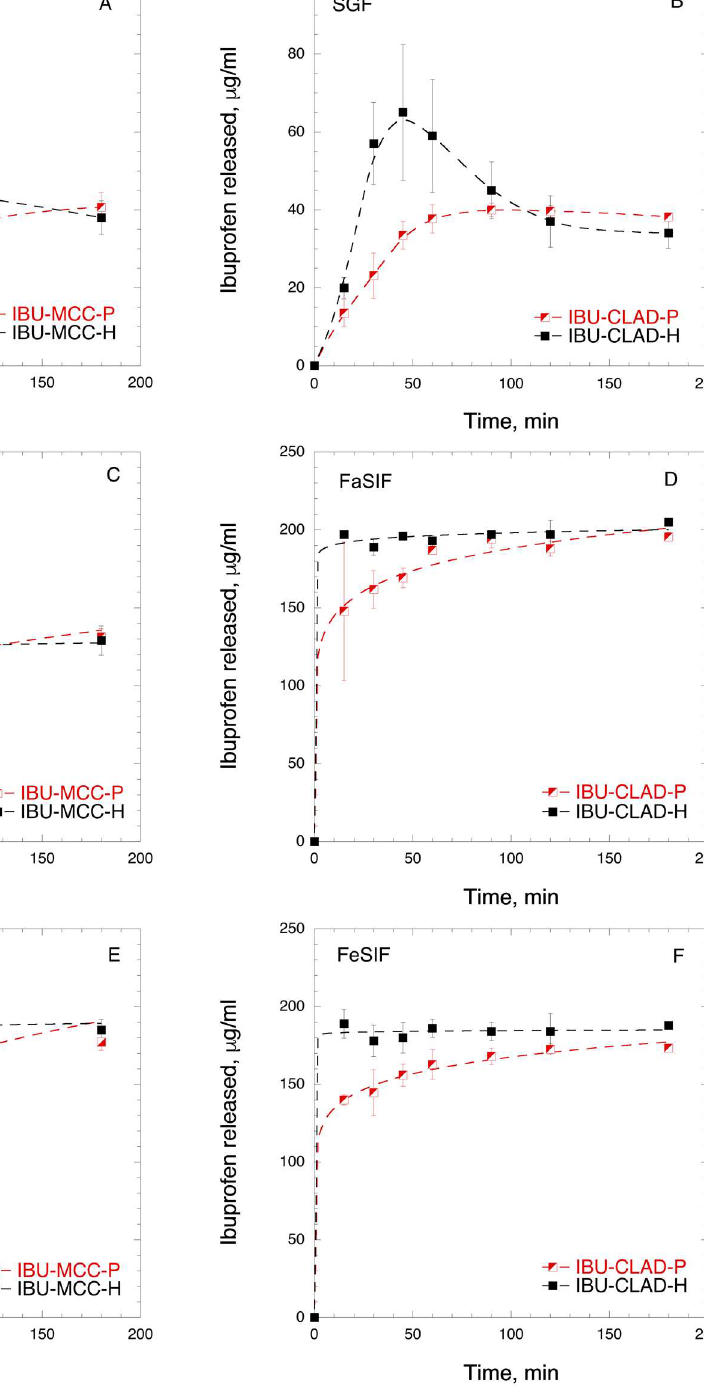
Figure 6. In vitro time-dependent IBU dissolution in biorelevant media: ( A ) IBU-MCC in SGF, ( B ) IBU-CLAD in SGF; ( C ) IBU-MCC in FaSIF; ( D ) IBU-CLAD in FaSIF; ( E ) IBU-MCC in FeSIF, and ( F ) IBU-CLAD in FeSIF 10 w / w mixtures. The results are the average of 3 measurements with standard deviation as error bars. The dashed line is guide for the eye.